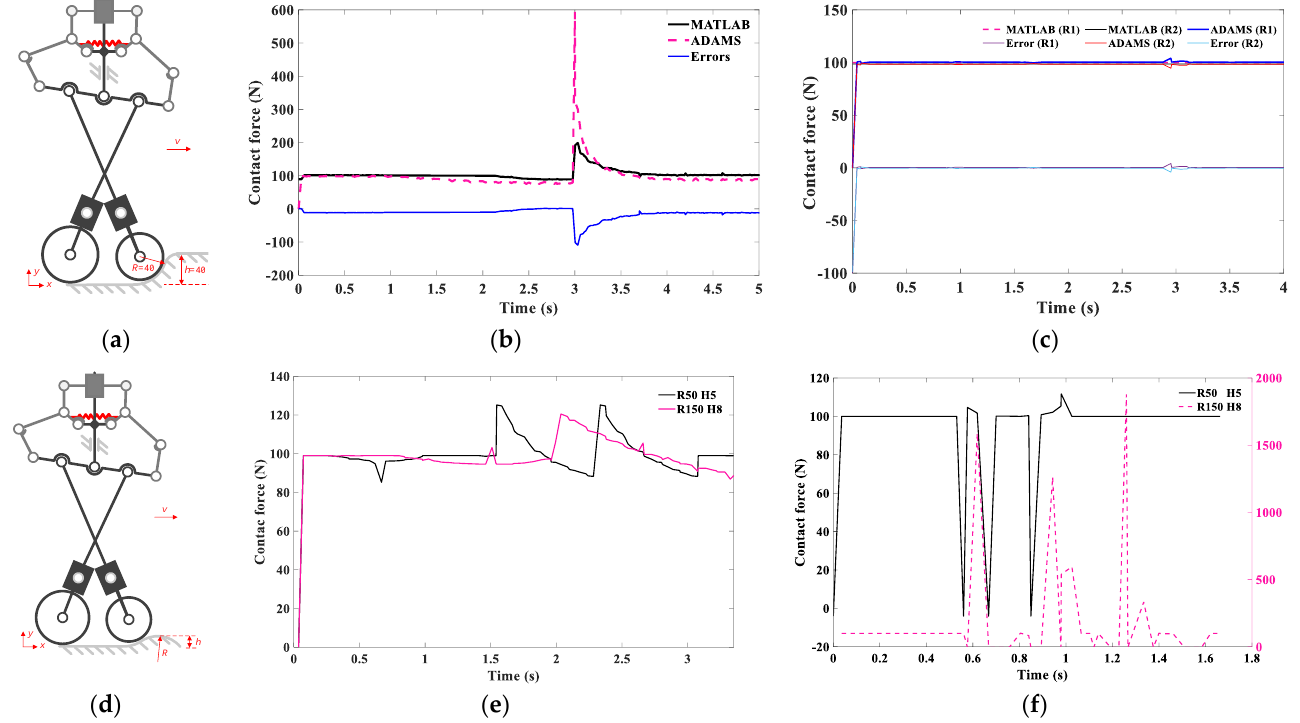
Figure 9. Results comparison. Here, ( a ) shows the schematic diagram of the mold’s geometric information for experiment A; ( b ) shows the MATLAB results in and the ADAMS results in the compliant state; ( c ) shows the MATLAB results in and the ADAMS results in the stiff state; ( d ) shows the schematic diagram of the mold’s geometric information for experiment C; ( e , f ) show the results for the force of experiments for different curved surfaces in ADAMS.